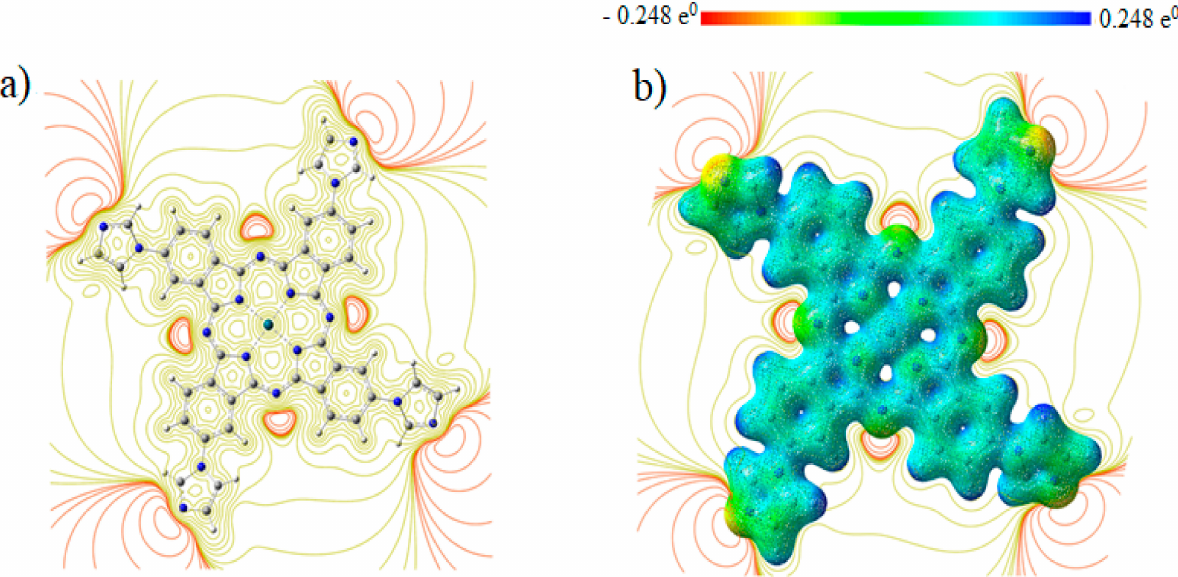
Figure 4. ( a ) Electrostatic potential surface and contours of PdPc(Im)4 from total SCF density (isoval = 0.025) in the plan of molecule (yellow = positive, orange = negative) and ( b ) a cross-section in terms of that mapped with electrostatic potential from total SCF density and contour